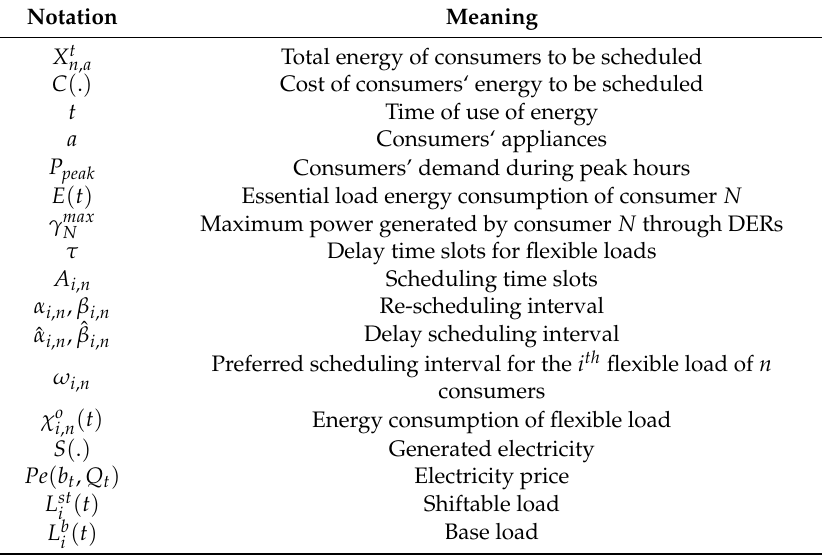
Table 2. Notations and symbols used in this